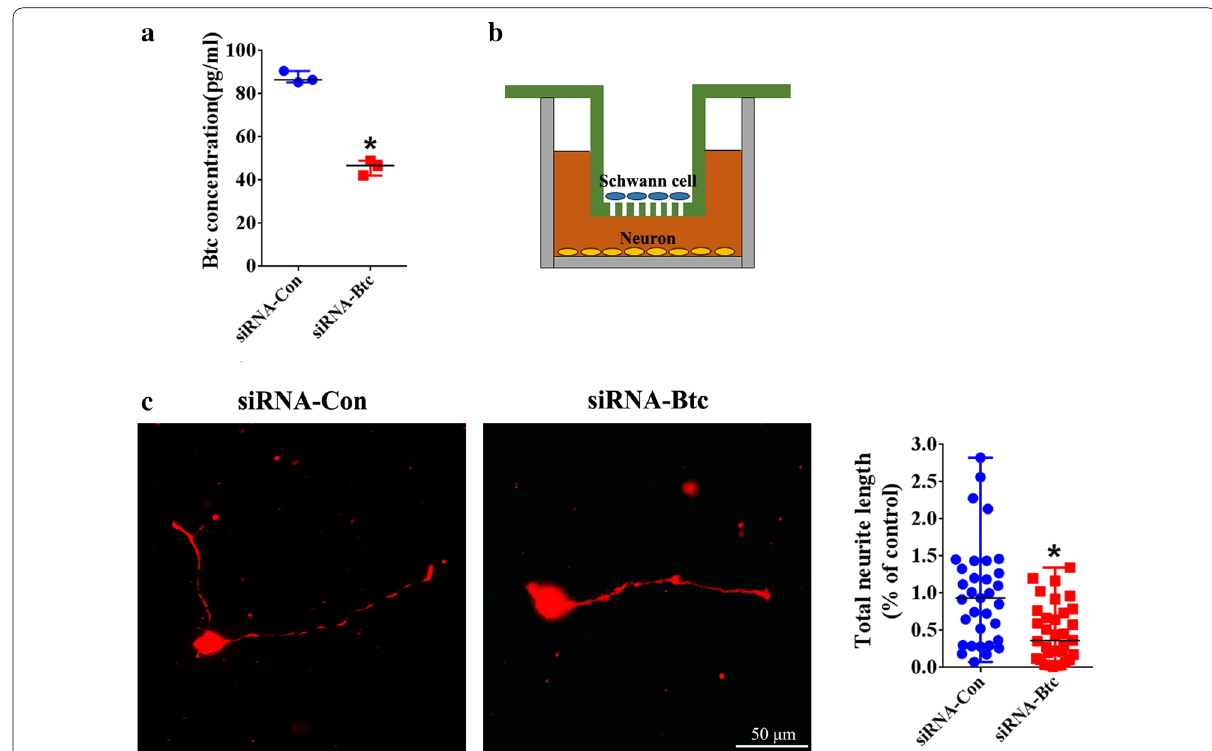
Fig. 4 The in vitro effect of Schwann cell-secreted Btc on axon elongation. a The amount of Schwann cell-secreted Btc in Schwann cells transfected with siRNA control or siRNA- Btc . The concentration of Btc was summarized from three experiments. Statistical evaluation was performed using t-test. *p-value < 0.05 versus siRNA control. b The schematic diagram of the co-culture of Schwann cells and neurons. c Representative immunofluorescence images and normalized neurite length of neurons co-cultured with transfected with siRNA control or siRNA- Btc . Scale bars represented 50 μm. Neurite length was summarized from three experiments. Statistical evaluation was performed using Mann–Whitney test. *p-value < 0.05 versus neurons co-cultured with Schwann cells transfected with siRNA